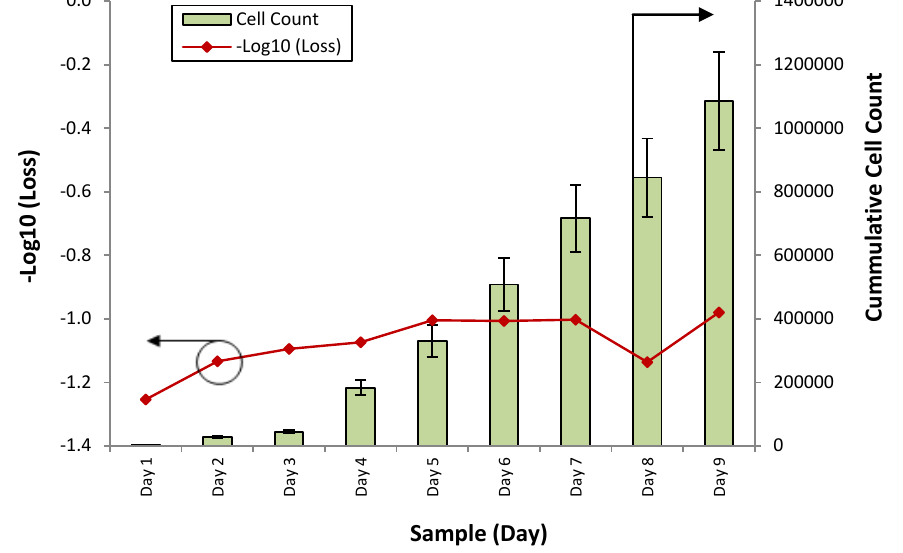
Figure 4. −Log (Power Loss) (dB) and cumulative cell count against different 10 conditioned media samples for the SCD.SC4 cell line. The power loss is represented by the line graph, with the corresponding X-axis on the left, while the cell count is represented by the bar chart, with the corresponding X-axis on the right side of the